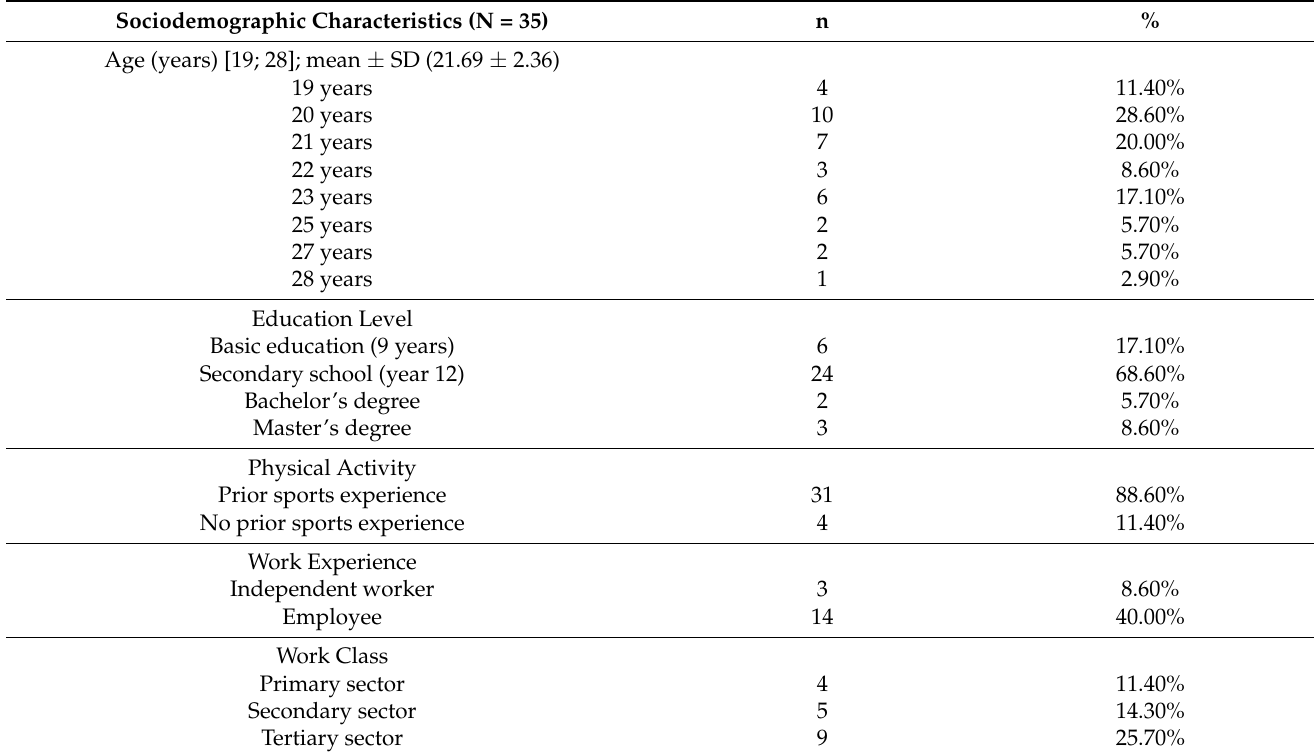
Table 1. Participants’ sociodemographic